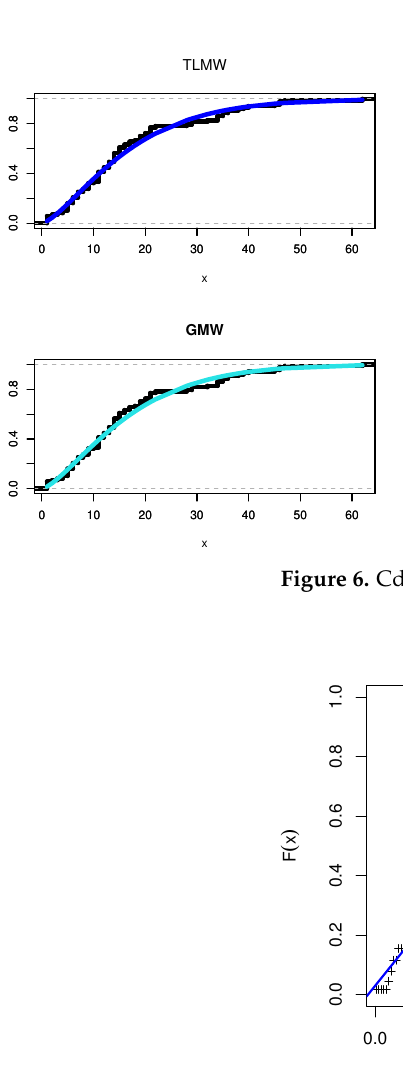
Figure 7. PP and QQ for TLMW model for COVID-19 data. The 95% CIs for the parameters α , β , θ and λ are presented for MLE and Bayesian estimation methods in Table 9. Figure 8 displayed contour plot of parameters for TLMW model to check uniqueness and max-value of likelihood for COVID-19 data. While, Figure 9 confirmed convergence of MCMC results, which show the MCMC samples as a pairs plot, with the trace plot, and marginal frequency of proposed distribution as normal distribution for each parameter on the diagonal for parameters of TLMW model for COVID-19 data. Figure 10 discussed Auto-correlation Function (ACF) test. Auto-correlation for MCMC is the correlation between a iteration series with a lagged version of itself. The ACF starts at a lag of 0, which is the correlation of the iteration series with itself and therefore results in a correlation of 1. Table 9. MLE and Bayesian estimation methods of the TLMW model parameters for COVID-19 data. MLE Bayesian Estimates SE Lower Upper Estimates SE Lower